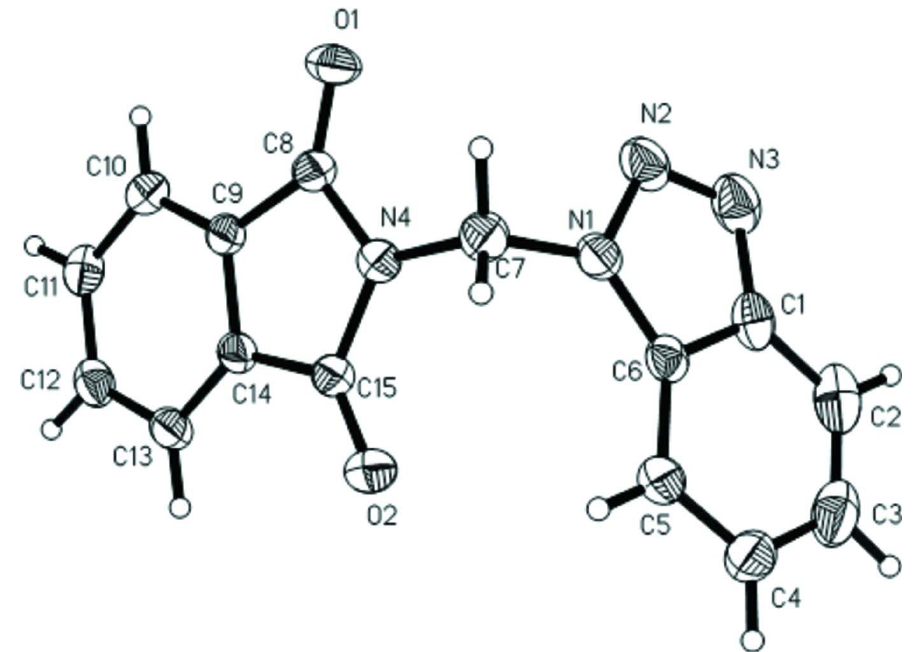
Figure 1 The molecular structure and atom-labeling scheme for (I), with displacement ellipsoids drawn at the 30% probability